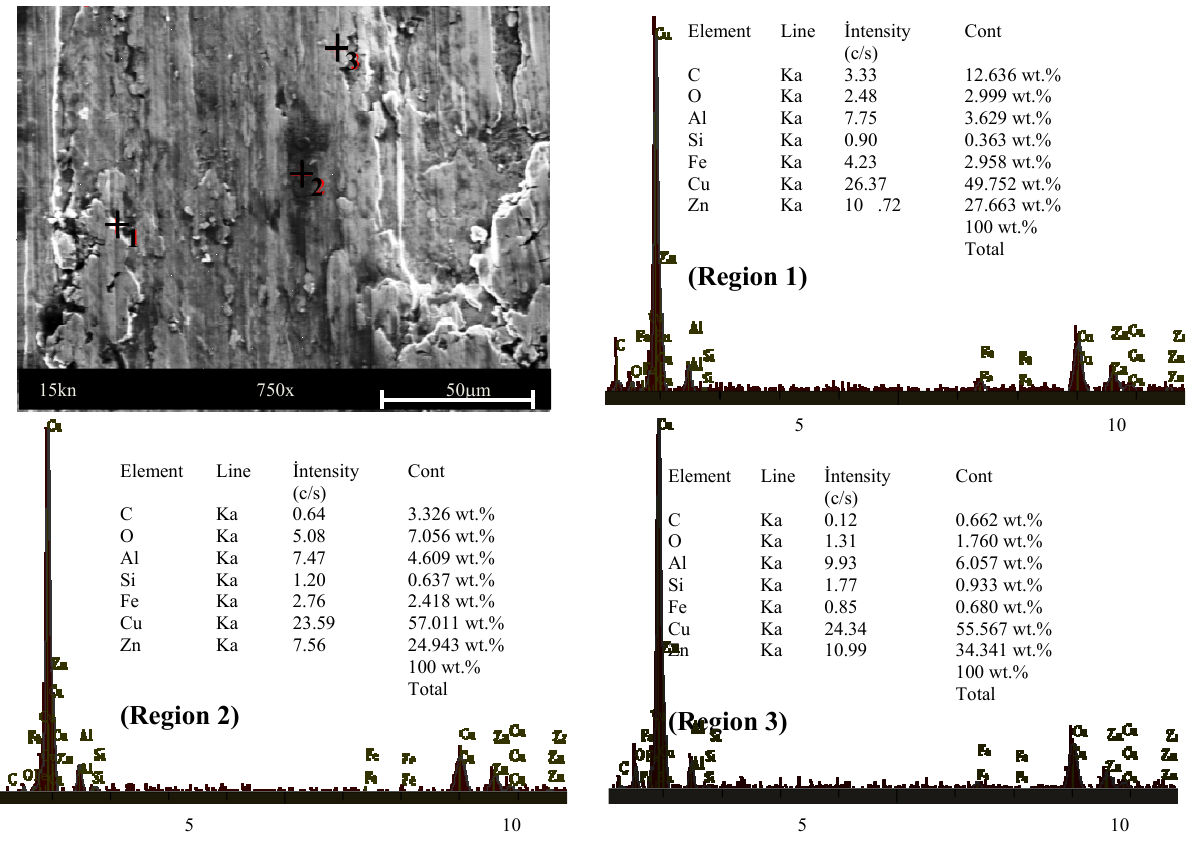
Figure 13. Worn surface SEM and EDAX analysis of centrically cast brass worn under loads of 40 N, at 0.3 m s (cid:3) 1 speed and against ferritic ductile iron